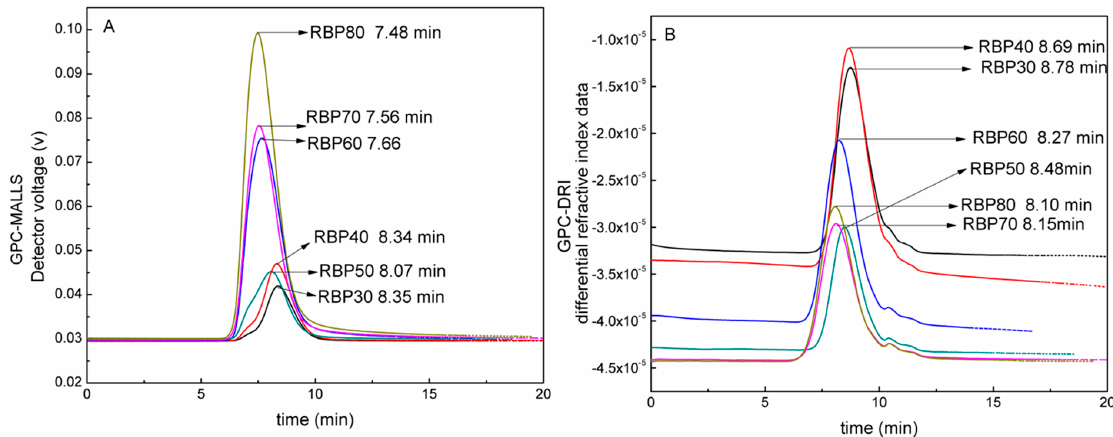
Figure 3. Gel permeation chromatography (GPC) analysis of RBPs. Table 2. Molecular weight and polydispersity index of RBPs.